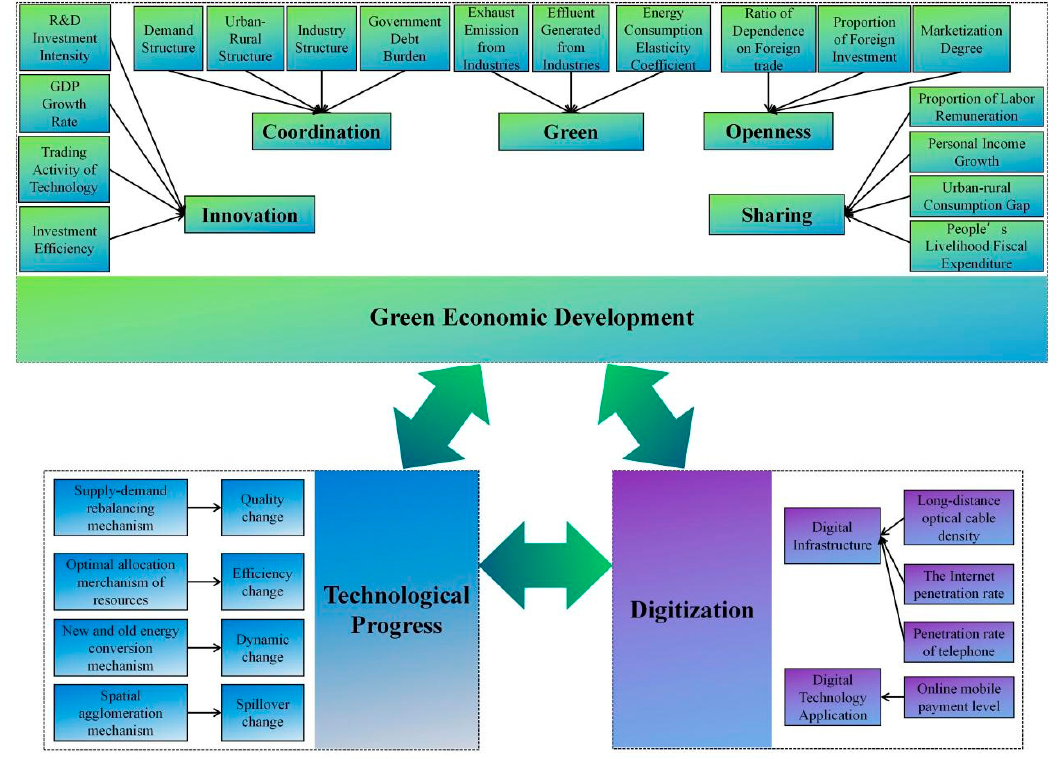
Figure 1. Theoretical framework (source: made by authors).